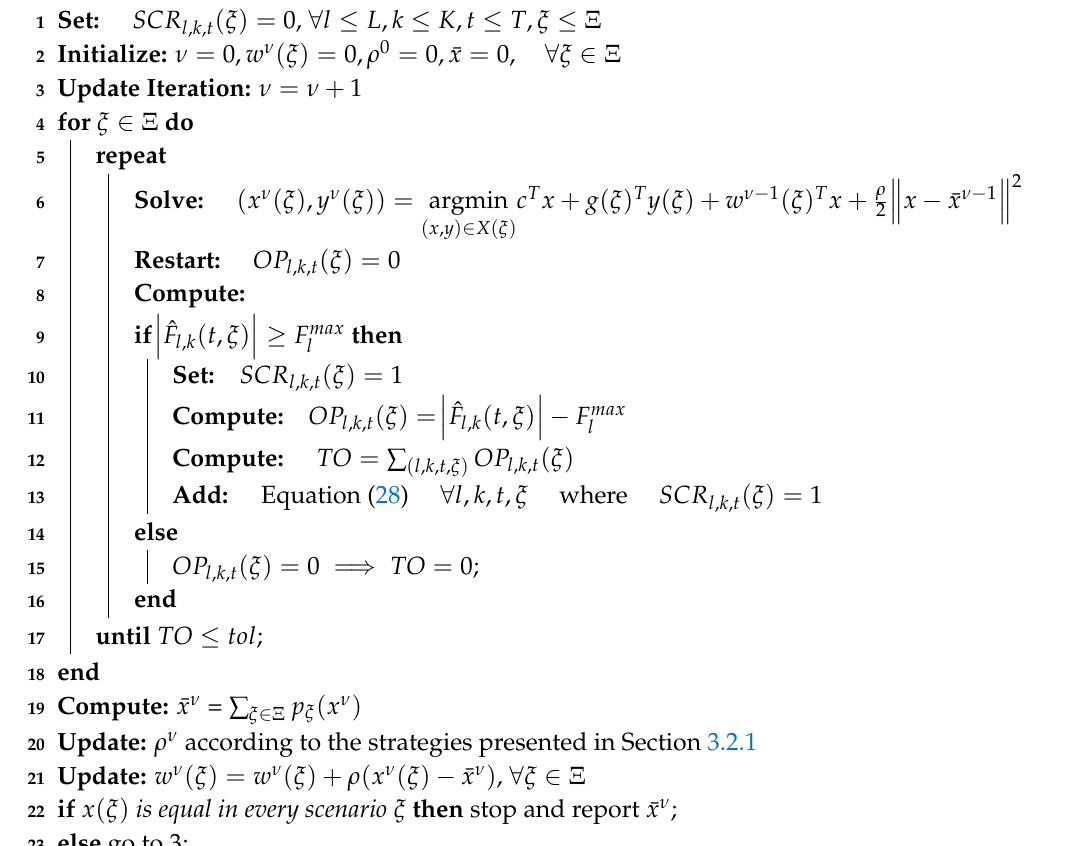
Algorithm 3: Method for Adding N − 1 Constraints Embedded Within the